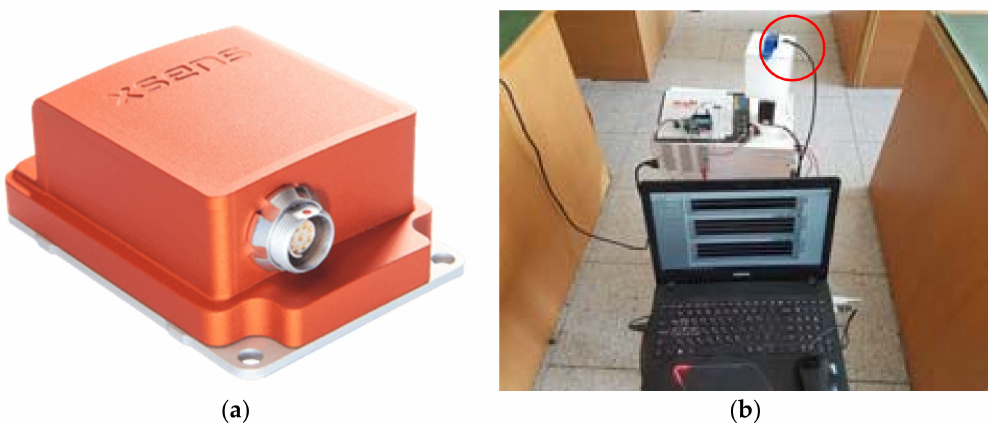
Figure 6. Wi-Fi and geomagnetic signal collection positions and structure for creating the radio map: ( a ) Geomagnetic sensor for experiment; ( b ) experimental system for collecting the geomagnetic and Wi-Fi